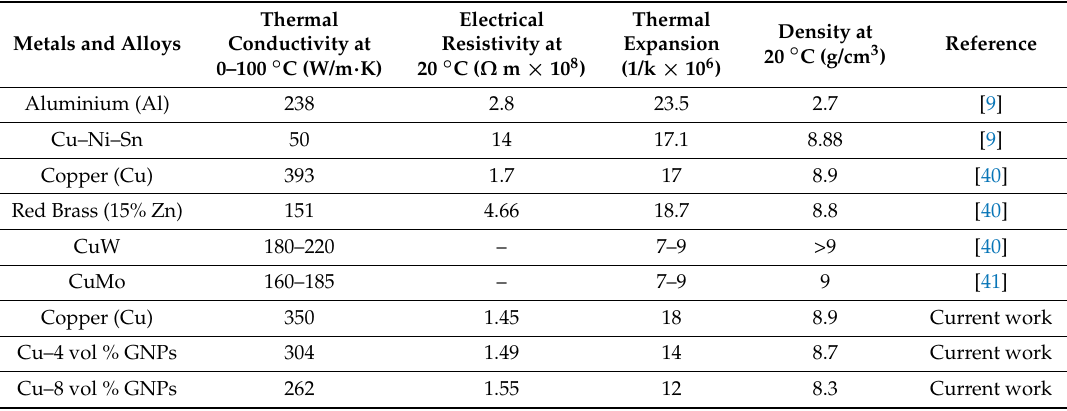
Table 3. Typical properties of some metallic materials used in electronic packaging.